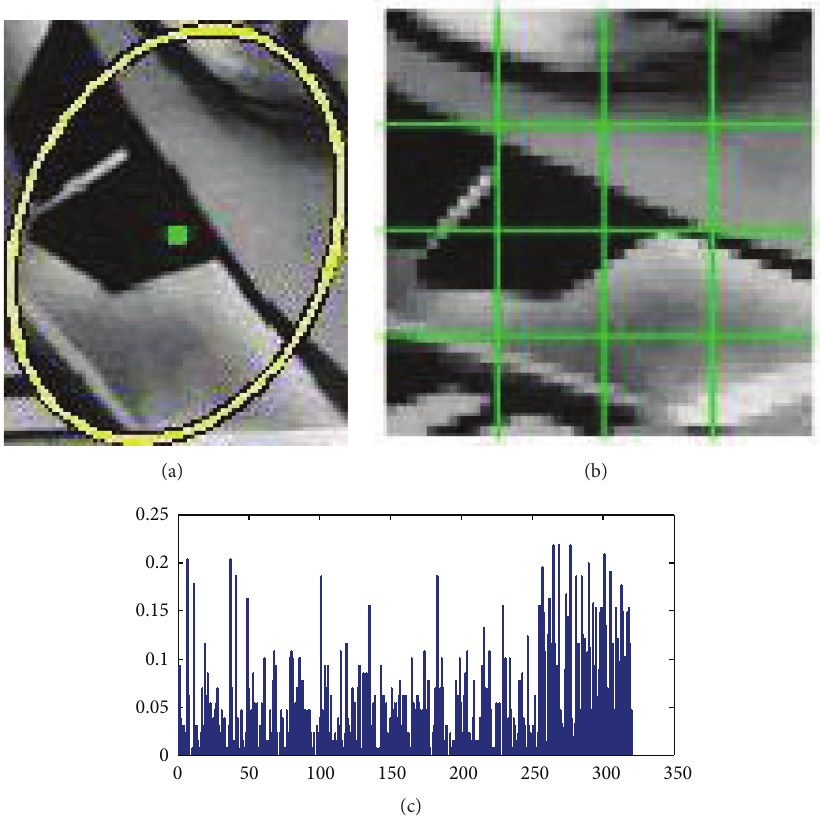
Figure 4: The construction of the CLDTP descriptor. (a) The detected affine invariant region. (b) The normalized region with grids. (c) The histogram of the CLDTP